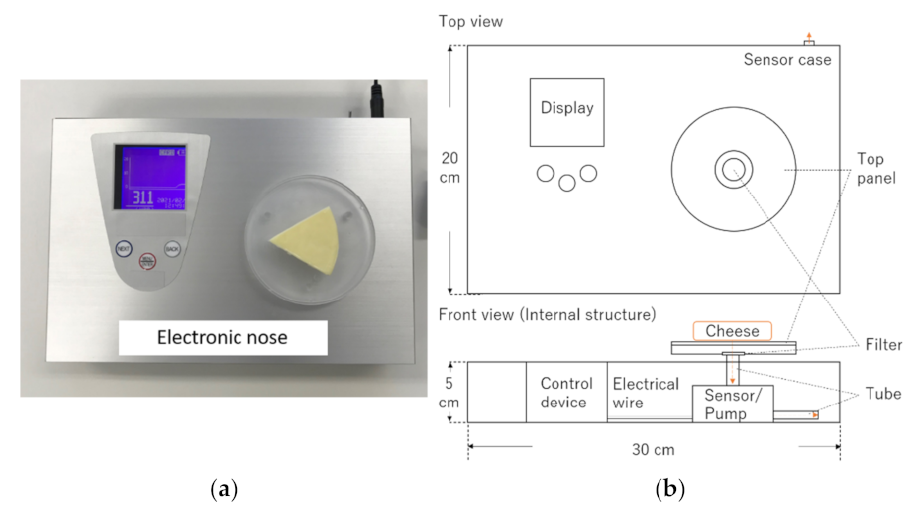
Figure 1. Electronic nose for sample bottom aroma: ( a ) measurement of a cheese sample; ( b ) diagram of the electronic nose.